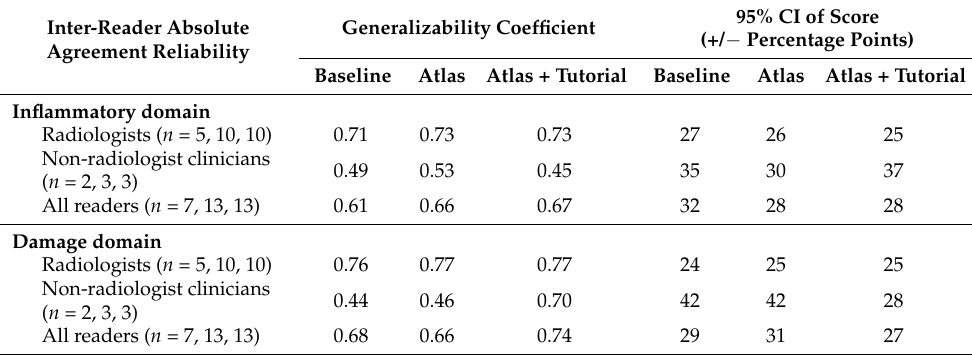
Table 2. Two-facet generalizability coefficients. Agreement on the TMJ score with two sources of variance—patient and reader. The 95% confidence interval of measurement reflects the measurement error interval around a given score, in the units of the respective JAMRIS